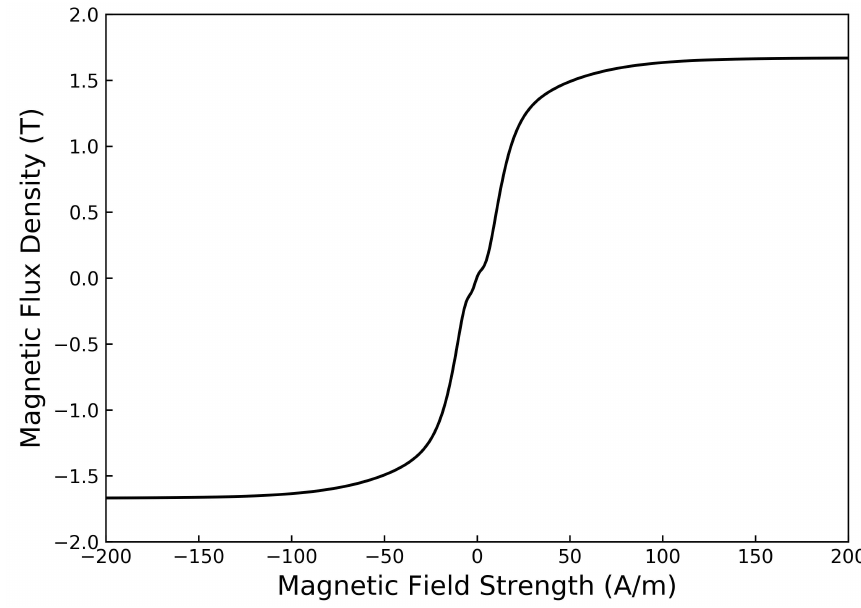
Figure 6. Magnetization curve calculated from DNN based on on-line experimental